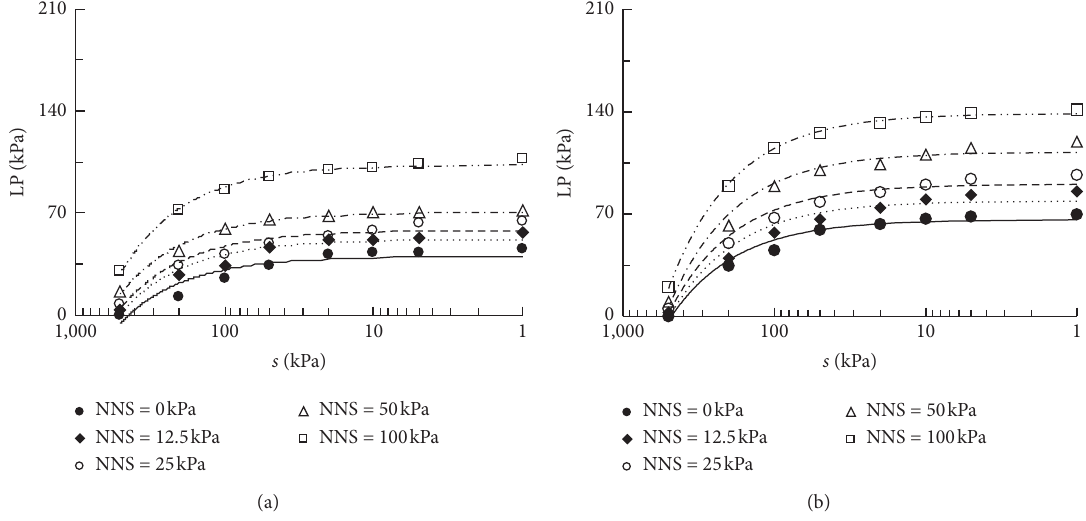
Figure 7: Variation of LP under different NNS with matric suction in (a) VS test and (b) LS test.